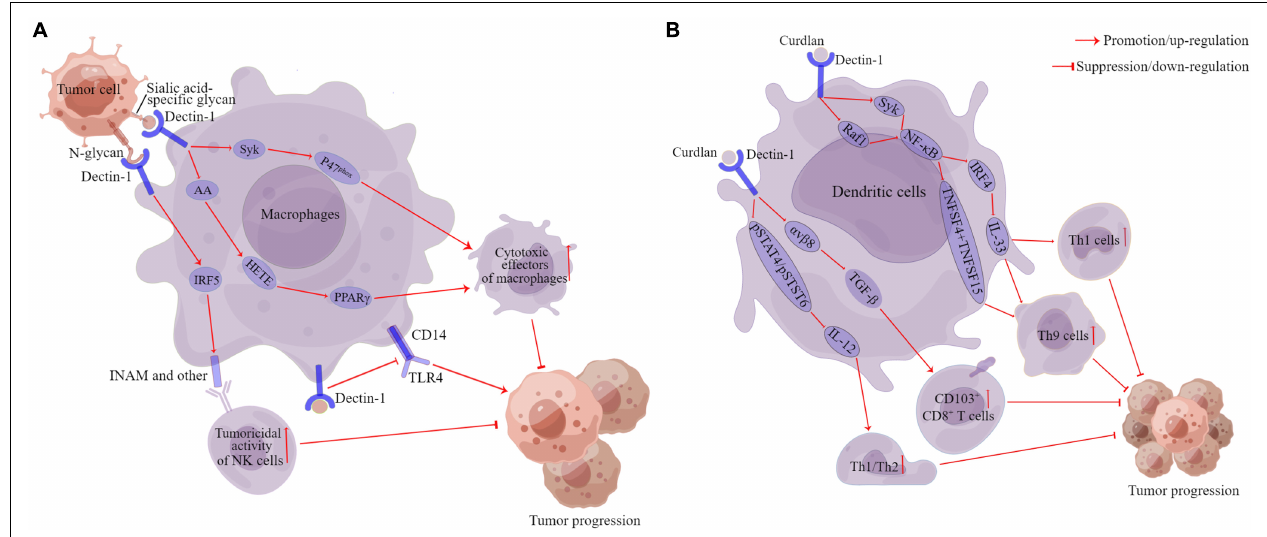
FIGURE 3 | The anti-cancer of Dectin-1 in cancers. Pathways of action of Dectin-1 in macrophages (A) . Pathways of action of Dectin-1 in dendritic cells (B) . DC, dendritic cells; AA, arachidonic acid; Syk, spleen tyrosine kinase; P47 phox , neutrophil cytosolic factor 1; HETE, the 12- and 15-hydroxyeicosatrienoic acids; PPAR γ , peroxisome proliferator-activated receptor-gamma; IRF5, interferon regulatory factor 5; INAM, family with sequence similarity 26 member F; TLR4, Toll-like receptor 4; Raf1, raf-1 proto-oncogene, serine/threonine kinase; IRF4, interferon regulatory factor 4; IL, interleukin; TNFSF15, tumor necrosis factor ligand superfamily member 15; TNFSF4, tumor necrosis factor ligand superfamily member 4; TGF- β , transforming growth factor-beta 1. α v β 8, α v β 8 integrin pSTAT4, phosphorylation of signal transducer and activator of transcription 4; pSTAT6, phosphorylation of signal transducer and activator of transcription 6. This figure was created using Figdraw